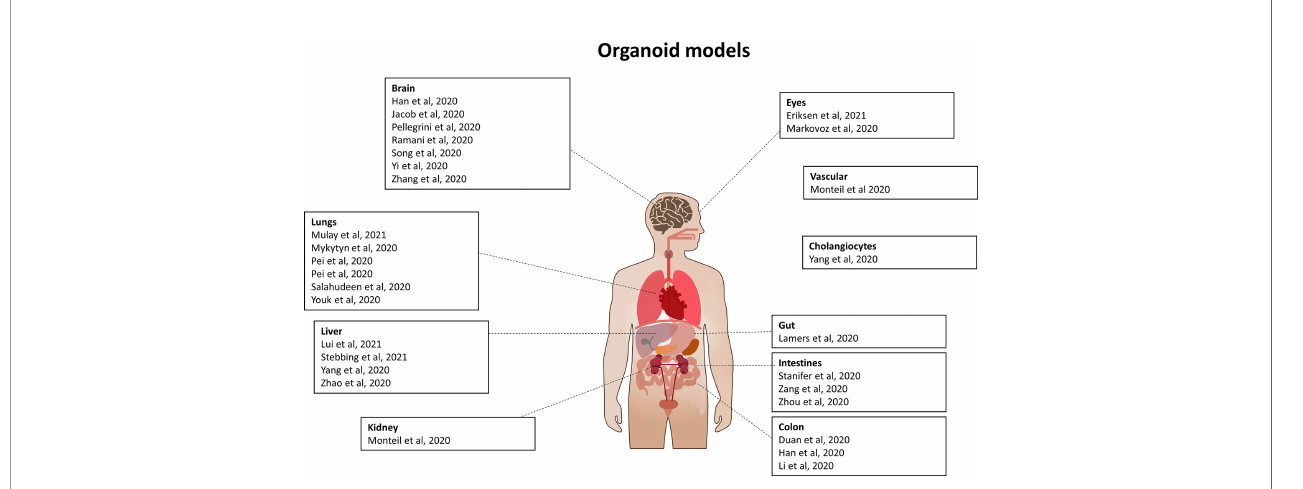
FIGURE 9 | Organoid models used for SARS-CoV-2 study. List of organoids which have been used to study SARS-CoV-2 infection, viral life cycle and/or for drug